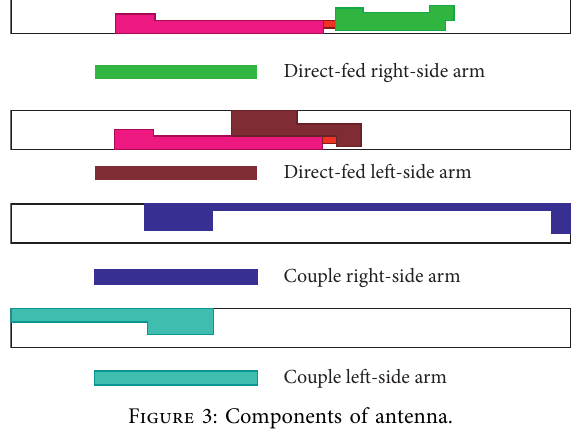
Figure 3: Components of antenna.